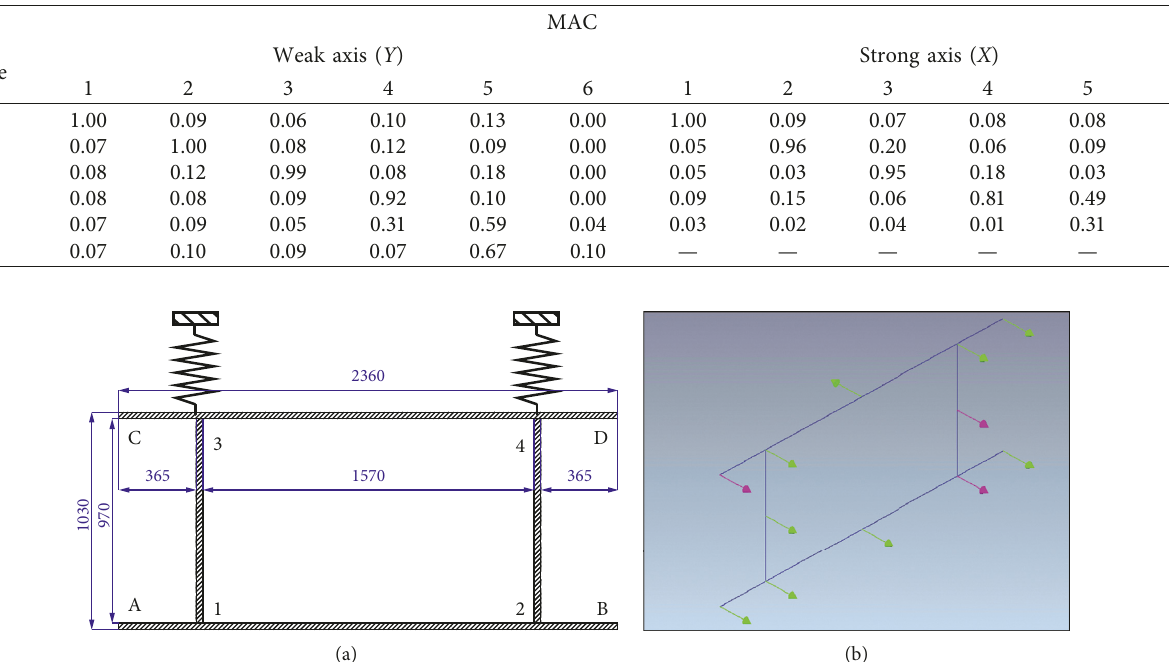
Table 7: MAC between experimental and predicted mode shapes.